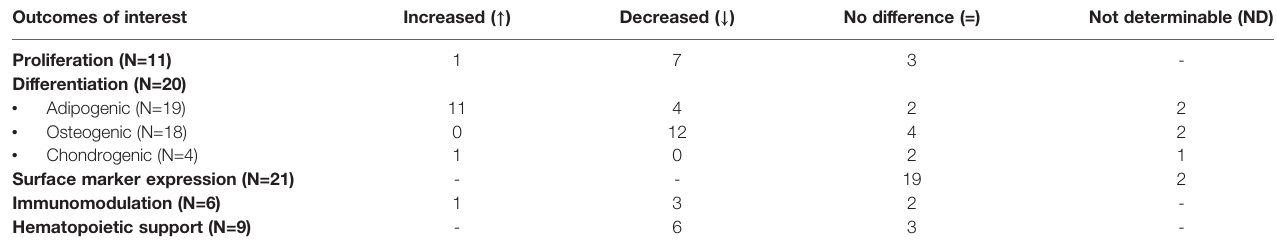
TABLE 10 | Summary of results for AA-MSCs per outcome of